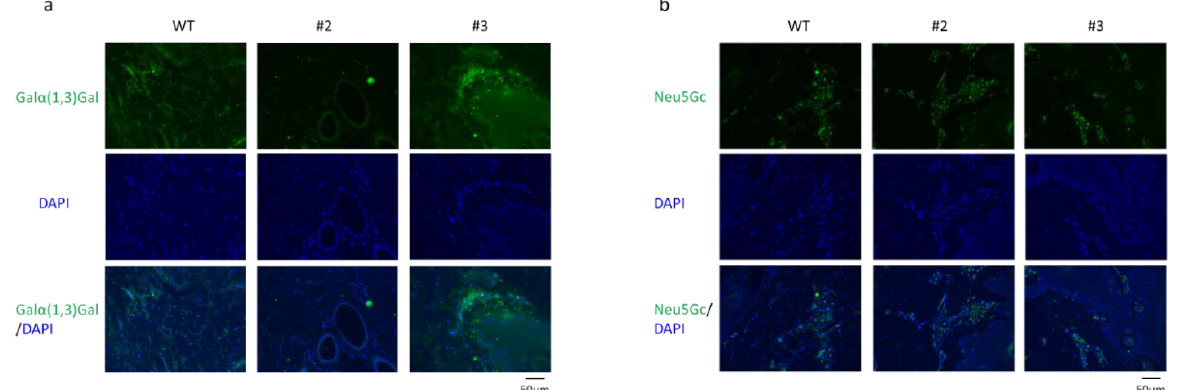
Figure 3. Immunohistochemical assessment of wild-type and GGTA1 / CMAH double-edited piglets. Ear biopsies derived from wild-type (WT) and GGTA1 / CMAH double-edited piglets (#2 and #3) were immunohistochemically stained for Gal α (1,3)Gal (green) ( a ) and Neu5Gc (green) ( b ). These tissues were counterstained with 4’, 6-diamidino-2-phenylindole (DAPI) (blue). The scale bar in each panel represents 50 μm.